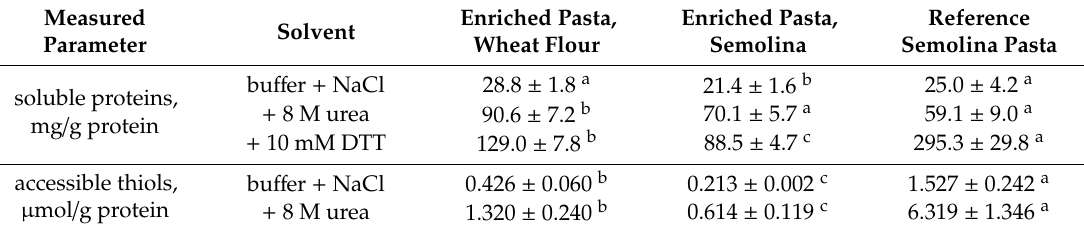
Table 1. Properties of the protein network in uncooked